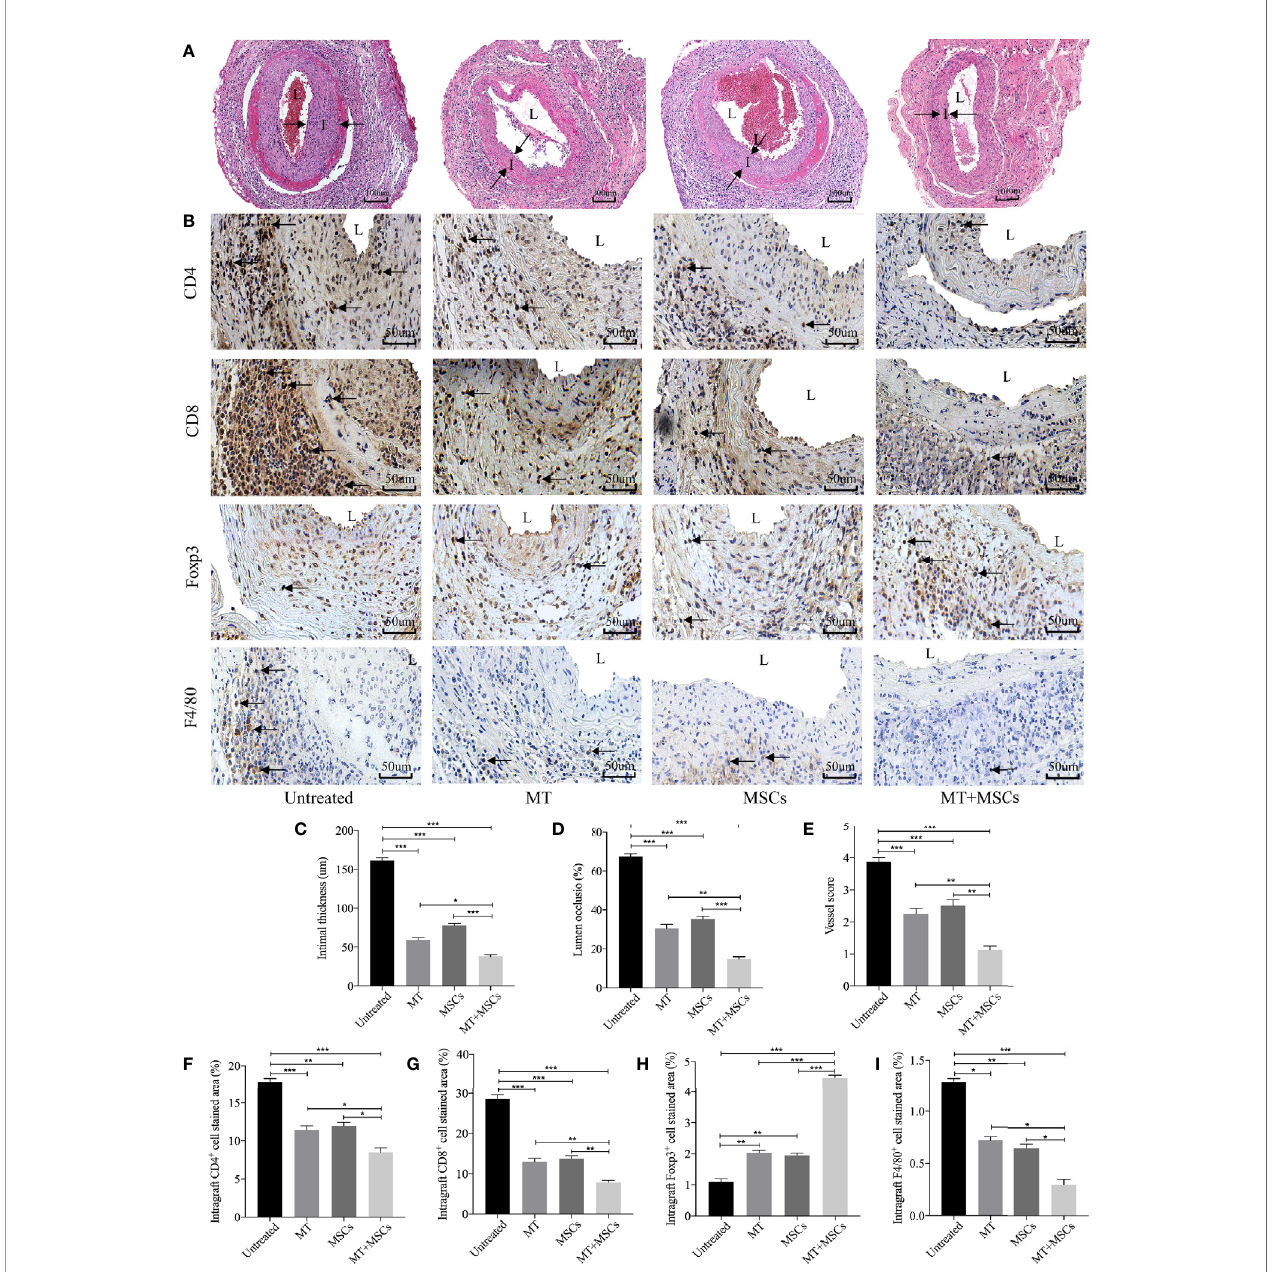
FIGURE 4 | MT synergized with MSCs signi fi cantly ameliorates CAV. Each section is displayed at 400× magni fi cation. “ I ” indicates neointima. “ L ” indicates lumen. (A) Histology of aorta allografts in transplant recipients; (B) Graft sections for immunohistochemical staining of CD4 + cells, CD8 + cells, Tregs and macrophages; (C) Intimal thickness of the aorta allografts in different groups; (D) Lumen occlusion of the aorta allografts in different groups; (E) Vessel score of the aorta allografts in different groups; (F) The percentage of intragraft CD4 + cells; (G) The percentage of intragraft CD8 + cells; (H) The percentage of intragraft Tregs; (I) The percentage of intragraft macrophages. Statistical analysis is performed by one-way analysis of variance (ANOVA), n = 10 per group, * p <.05, ** p <.01, and *** p <.001. Bar graphs represent mean ± SEM. MT, melatonin; MSCs, mesenchymal stromal cells. The experiments were repeated three times